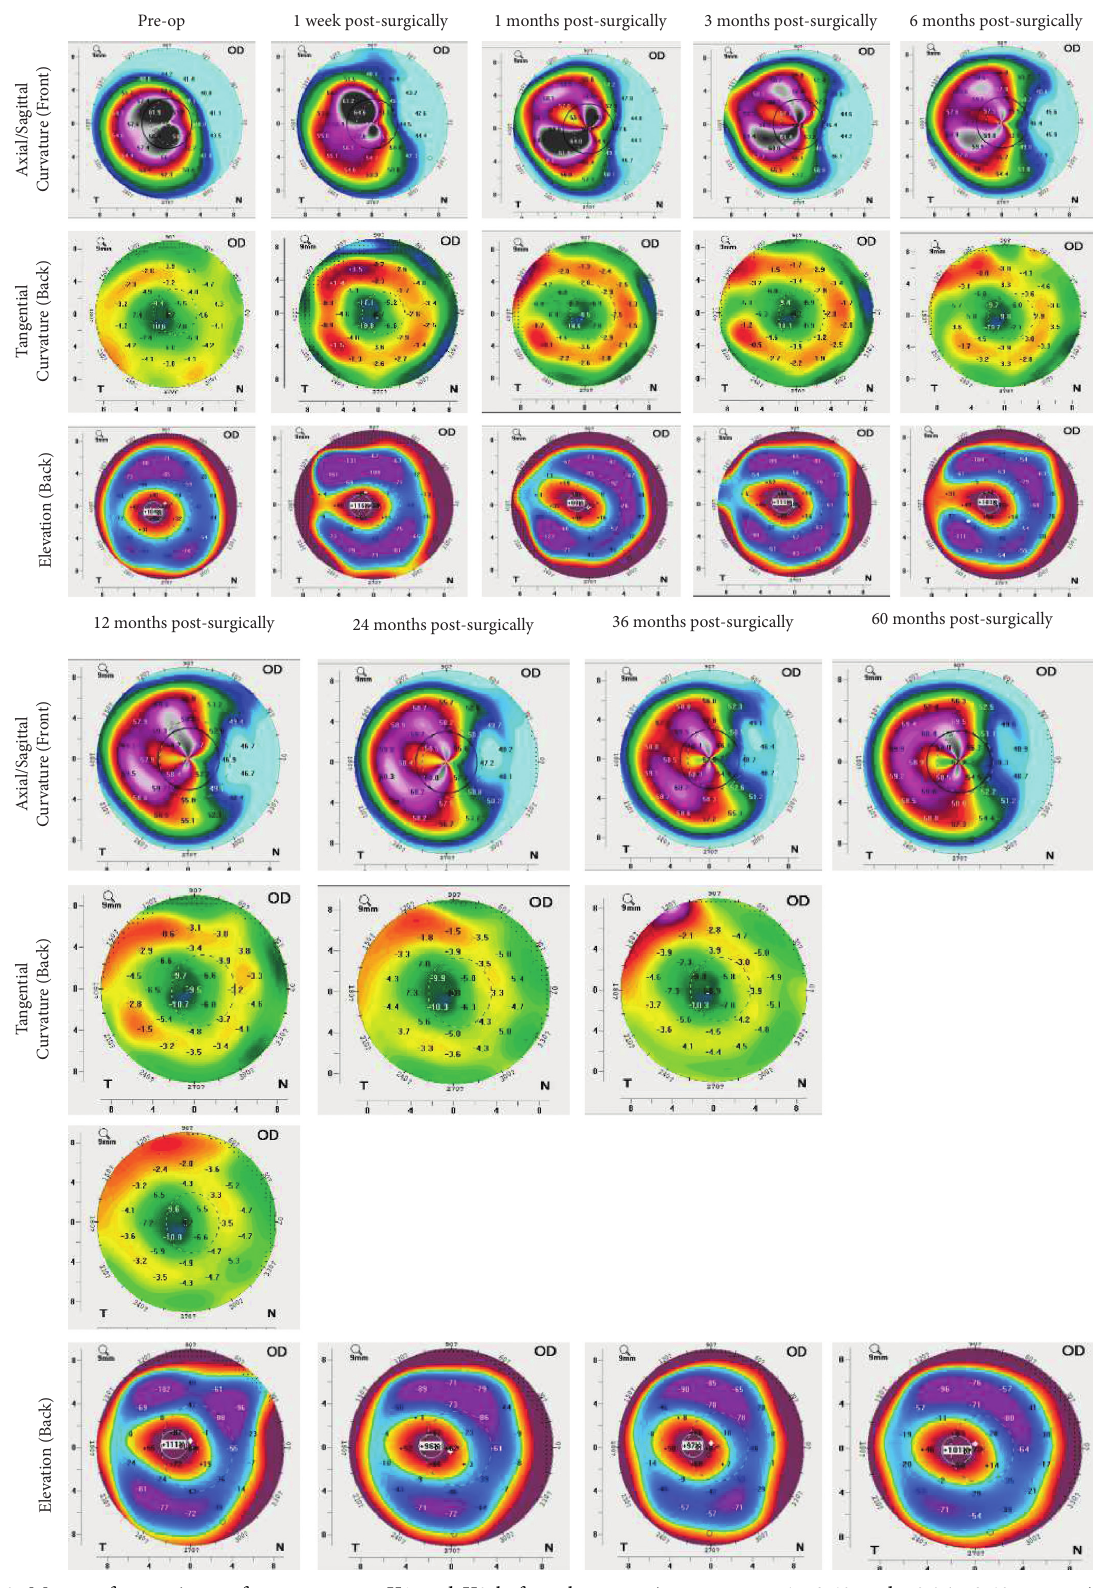
Figure 3: Means of posterior surface curvatures K1 and K2 before the operation were − 7.74 ± 0.43 and − 8.96 ± 0.48, respectively, and remained stable after surgery. At 60 months postsurgically, the posterior surface curvature K1 and K2 were − 7.98 ± k0.50 and − 9.11 ± 0.55, respectively, with no significant change as compared to the preoperative values. The mean of corneal posterior surface height, which is an indicator of surgical stability, was 94.14 ± 13.67 μ m preoperatively and 96.01 ± 12.96 μ m at 60 months postsurgically, without significant change relative to the preoperative